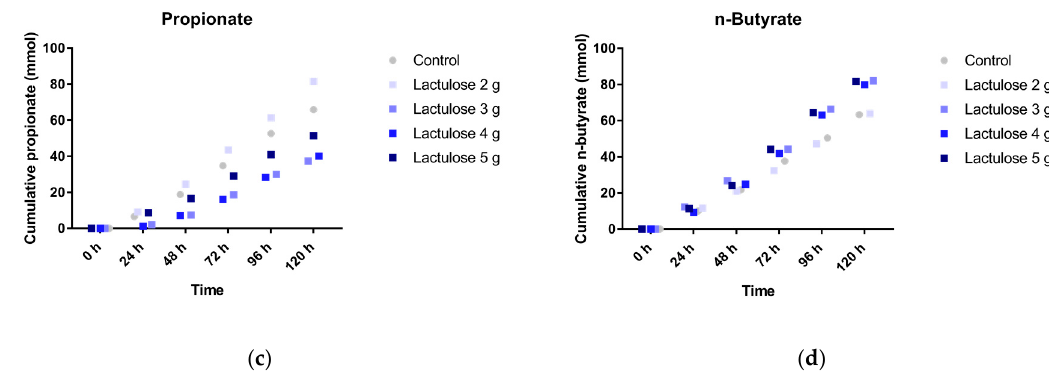
Figure 2. Production of ( a ) total short chain fatty acids (SCFA); ( b ) acetate; ( c ) propionate; and ( d ) butyrate in TIM-2 runs (mean of n = 2 (Lactulose dosages) or n = 4 (control)) with different dosages of Lactulose. Values at the start of the test period were set to zero. All data points shown at the proximity of the individual time points indicated at the X -axis belong to these specific time points.